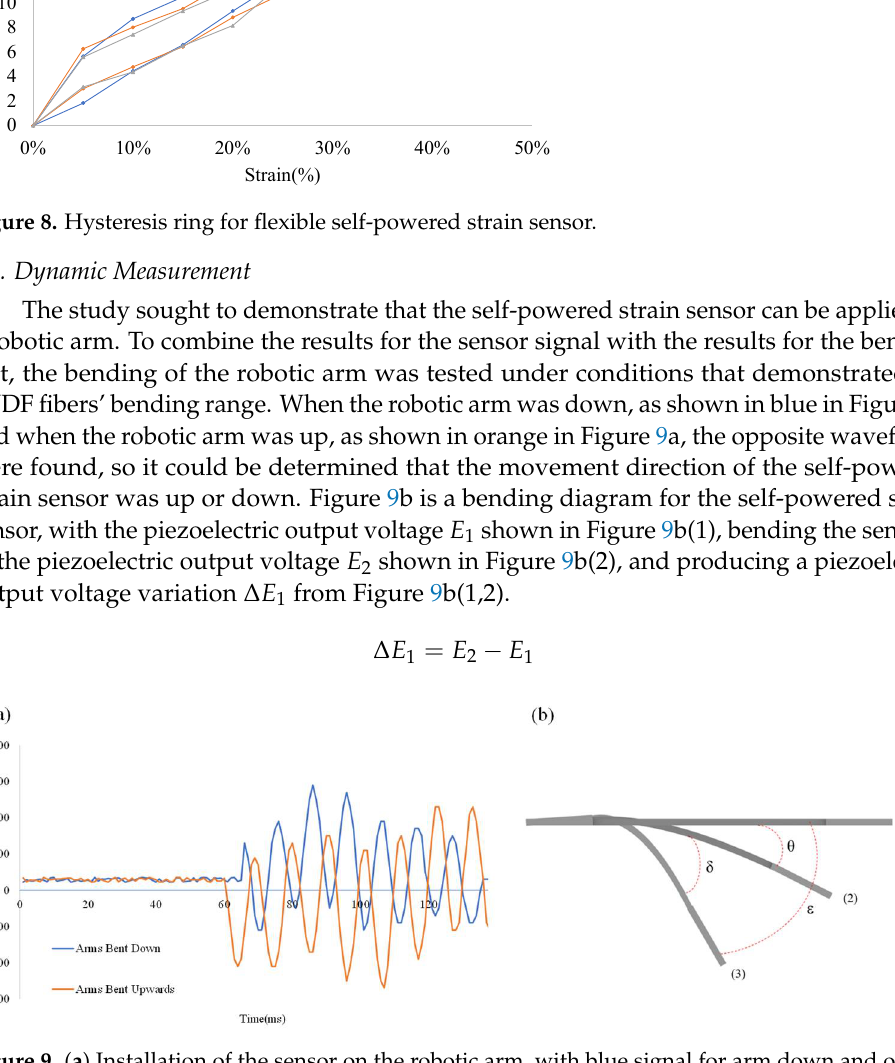
∆ E 2 : Corresponding to Figure 9b, a bending angle value of